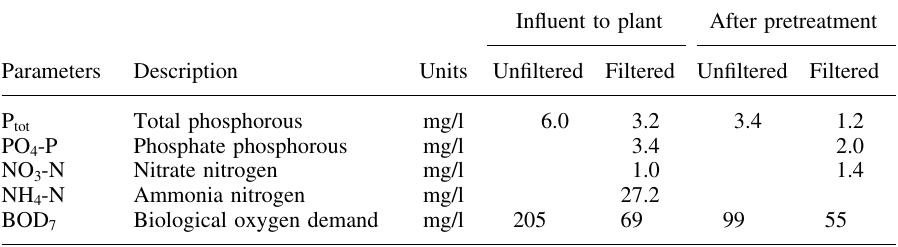
Table 2. Description of typical influent concentrations to the Duvbacken Waste Water Treatment Plant.